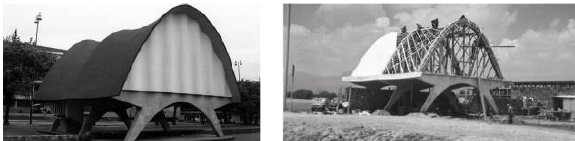
Figure 2. Left: Cosmic Rays Pavilion, Mexico City, 1951 (Architectuul [website], 2019) Right: Cosmic Rays Pavilion in Construction, Mexico City (Del Cueto,